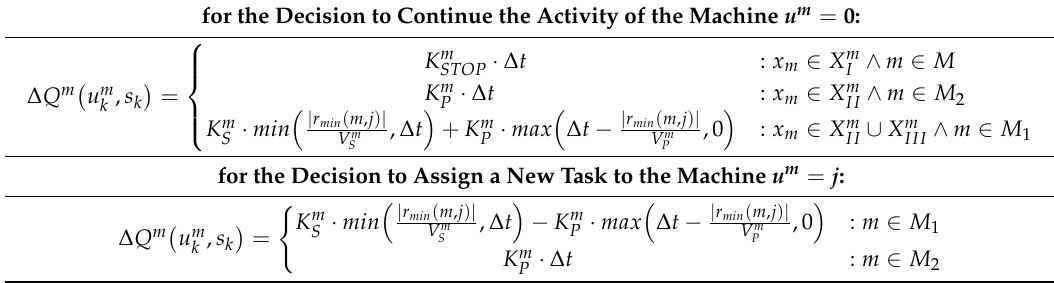
Table 2. Cost increase for machine m